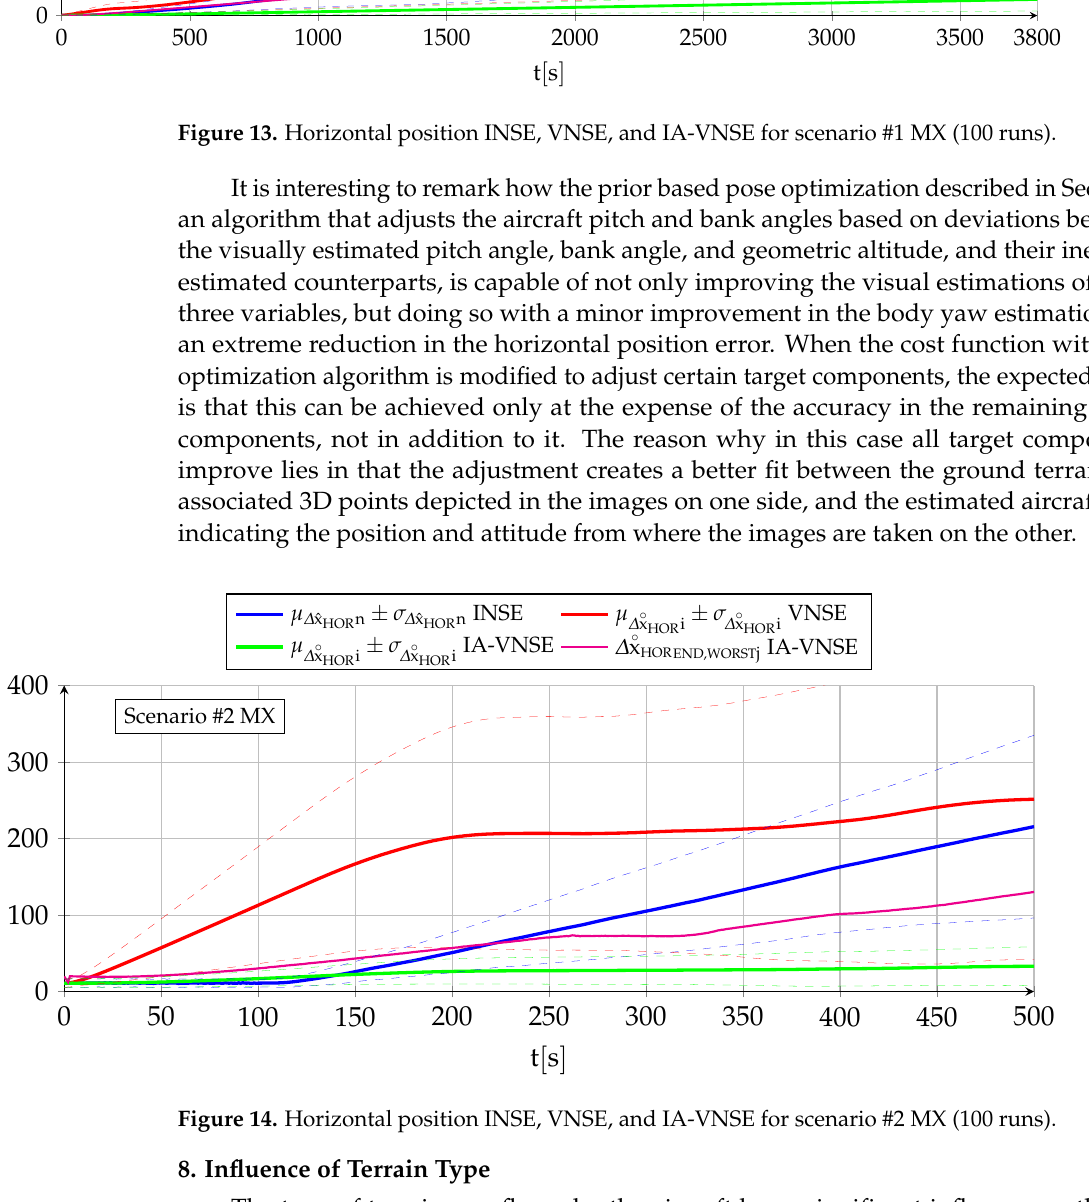
Figure 13. Horizontal position INSE, VNSE, and IA-VNSE for scenario #1 MX (100 runs). The IA-VNS (green lines) results in major horizontal position estimation improvements over the VNS. The final horizontal position error mean µ to 0.46 % for scenario #1, and from 1.77 to 0.23 % for scenario #2. The repeatability of the results also improves, as the final standard deviation σ